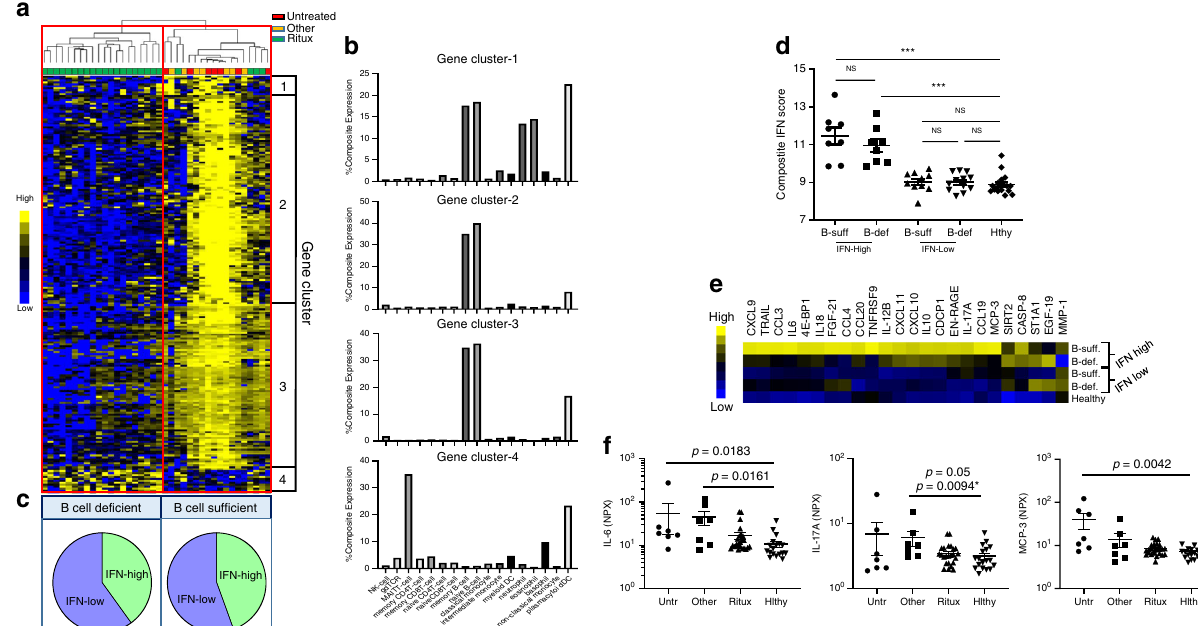
Fig. 3 Effects of B-cell-depleting therapy (BCDT) in IFN-high and IFN-low NMOSD patients. a Heatmap depicts the hierarchical clustering of NMOSD patients (Red = NMO-Untreated, Yellow = NMO-Other Tx, Green = NMO-Ritux) based on differentially expressed genes (DEGs) of patients treated with rituximab ( n = 24) compared with patients not treated with rituximab ( n = 14). Hierarchical clustering of the DEGs grouped genes into four clusters (Gene clusters 1 – 4). Yellow represents elevated gene expression and blue represents reduced gene expression. b Percent expression of genes in clusters 1 – 4 per cell type. c Strati fi cation of NMOSD patients into two groups, de fi ned as B-cell-de fi cient and B-cell-suf fi cient, based on gene expression and pie chart depicting the distribution of IFN-high and IFN-low NMOSD patients in the B-cell-de fi cient and B-cell-suf fi cient groups. d Composite IFN scores (average read count of IFN-I genes) of B-cell-suf fi cient IFN-high patients ( n = 8), B-cell-de fi cient IFN-high patients ( n = 8), B-cell-suf fi cient IFN-low patients ( n = 10), B-cell-de fi cient IFN-low patients ( n = 12) and healthy individuals ( n = 18). e Heatmap indicating relative protein levels in IFN-high and IFN-low NMOSD patients from B-cell-suf fi cient or B-cell-de fi cient groups. f Serum protein levels of IL-6, IL-17A, and MCP-3 in untreated ( n = 7), Other-treated ( n = 7), and rituximab-treated NMOSD ( n = 24) patients compared with healthy controls ( n = 18). P values were determined using two-tailed Kruskal – Wallis tests